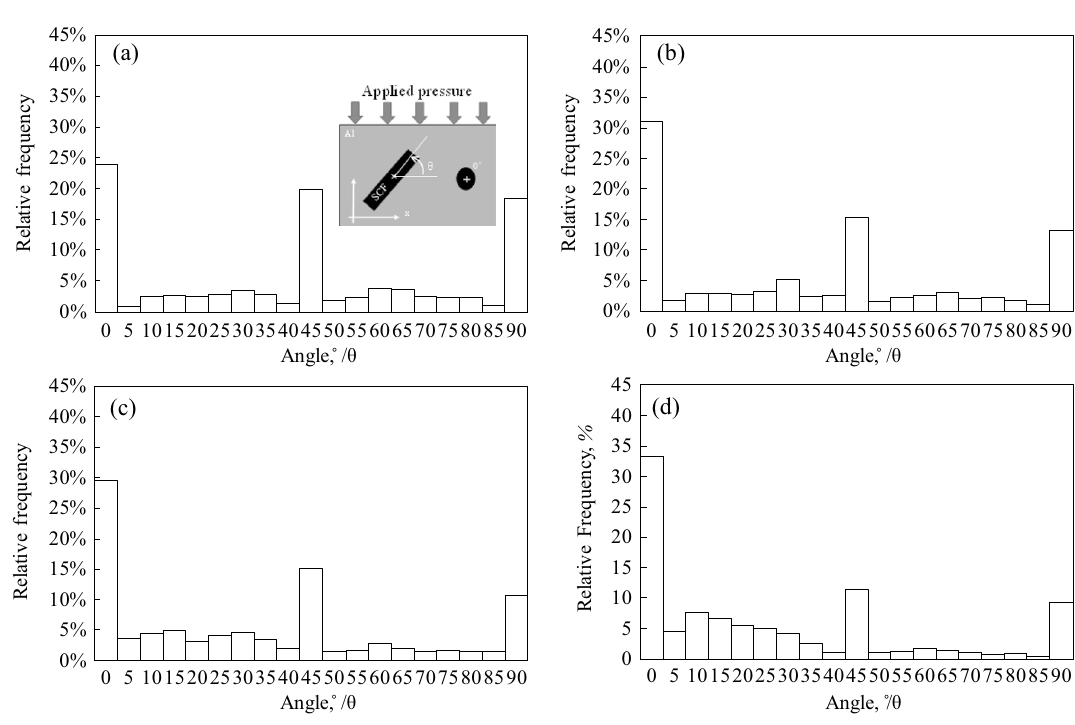
Figure 7. Relative frequency distribution of SCFs in cross-section of composites: ( a ) Cu-plated SCF (7.1 vol%)/ Al composite, ( b ) Cu-plated SCF (14.3 vol%)/Al composite, ( c ) Cu-plated SCF (29.1 vol%)/Al composite, and ( d ) SCF prefrom of 10 vol% with SiO 2 binder /Al